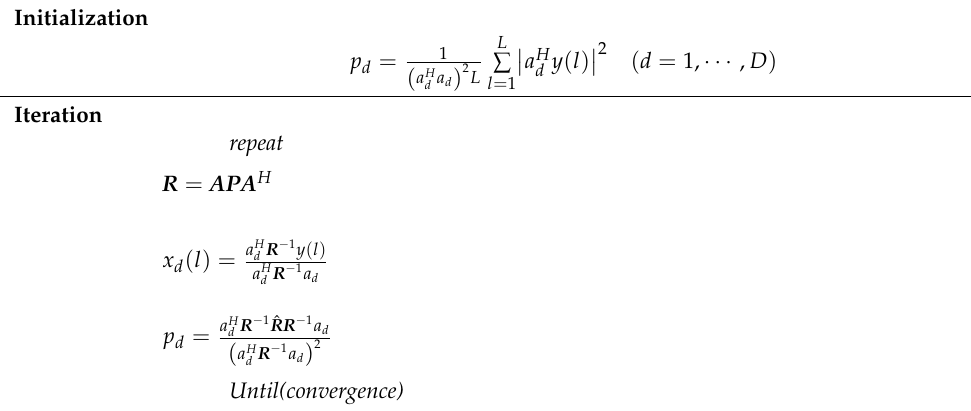
Table 1. Main steps of the IAA